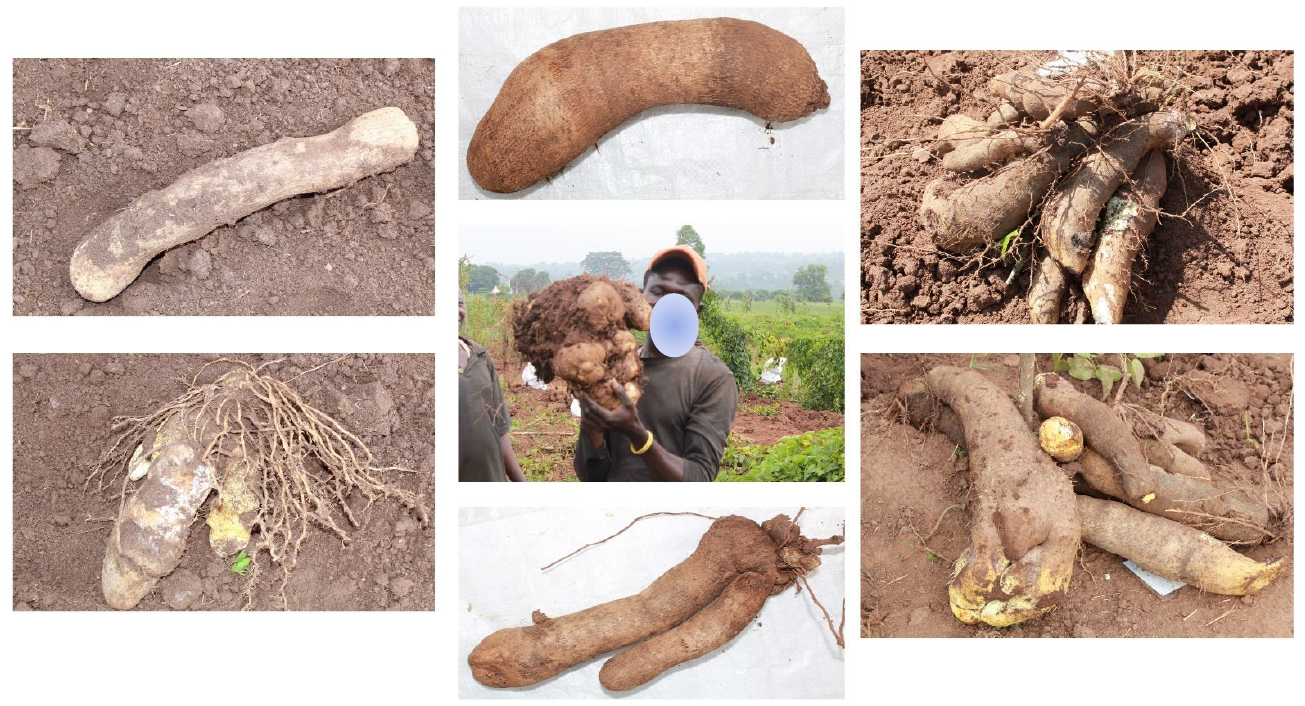
Figure 2. Pictures of harvested tubers from experimental sites. Mean yam dry matter content ranged from 25.1% to 33.5%, with an average of 28.4% across test environments. The genotype with least dry matter content across the envi- ronments was UGY16069 (25.1%), while UGY16064 (33.5%) registered the highest DMC (Table 8). Arua 2021 had the highest mean dry matter content of 31.6% followed by Namu- longe 2020 with a mean dry matter content of 30%. The lowest performing environments were Serere 2020 and Serere 2021 with mean dry matter content of 25.1% and 27.2%, respectively (Table Table 8. Mean dry matter content of 20 yam genotypes evaluated in six environments within Uganda.